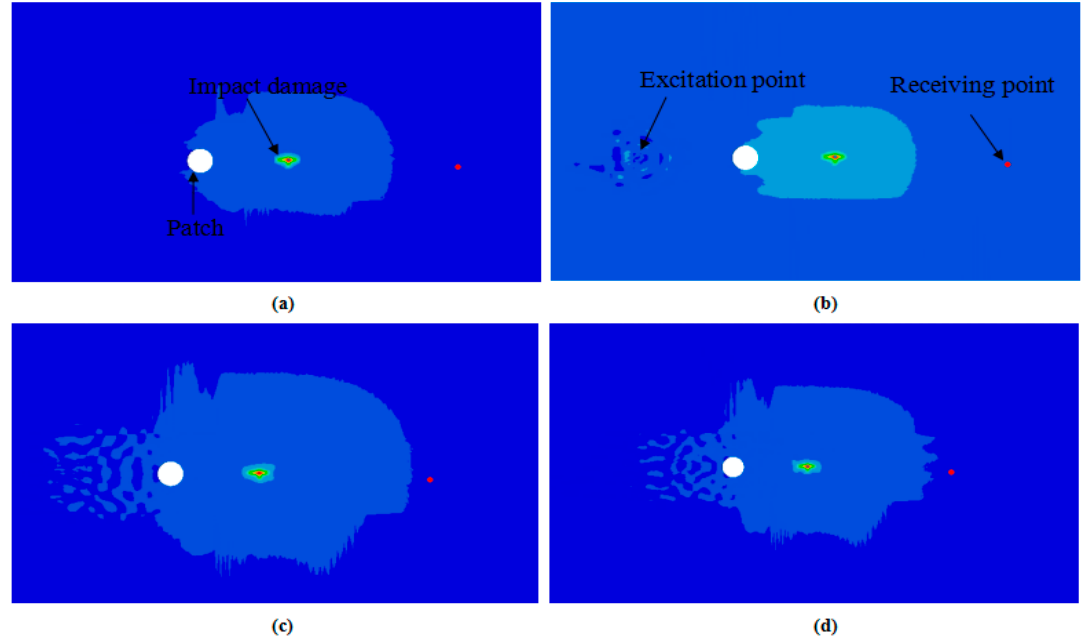
Figure 7. Frame sequence of the nonlinear Lamb wave propagation in LVI damage patch-repair CFRP laminates: ( a ) 0 µs, ( b ) 10 µs, ( c ) 20 µs and ( d ) 35 µs.